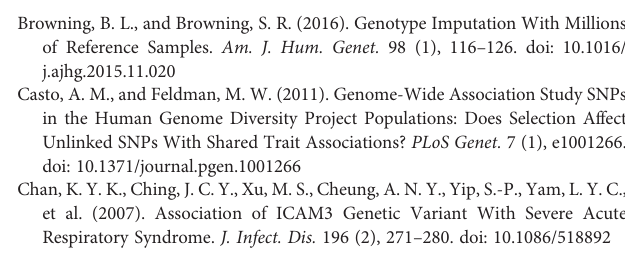
Supplementary Figure 1 | Results of gene-based association tests of rare variants. (A) .TheQQplotsofgene-basedassociationanalysesbetweensevereand non-severe patients for (A) 42,730 candidate rare variants; (B) 38,548 rare likely- deleterious missense variants, and (C) 4182 high-con fi dence pLoF variants. The color represents different association methods integrated in KGGseq, including SKAT test (in blue), SKAT-O (in red), and burden test (in